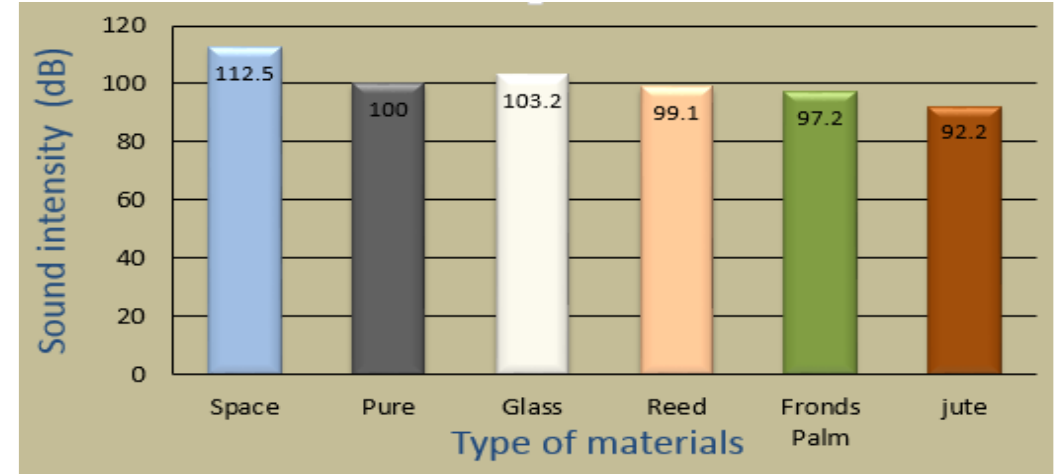
Fig.11: Comparison between the sound level intensity for natural fibers with Glass fibers